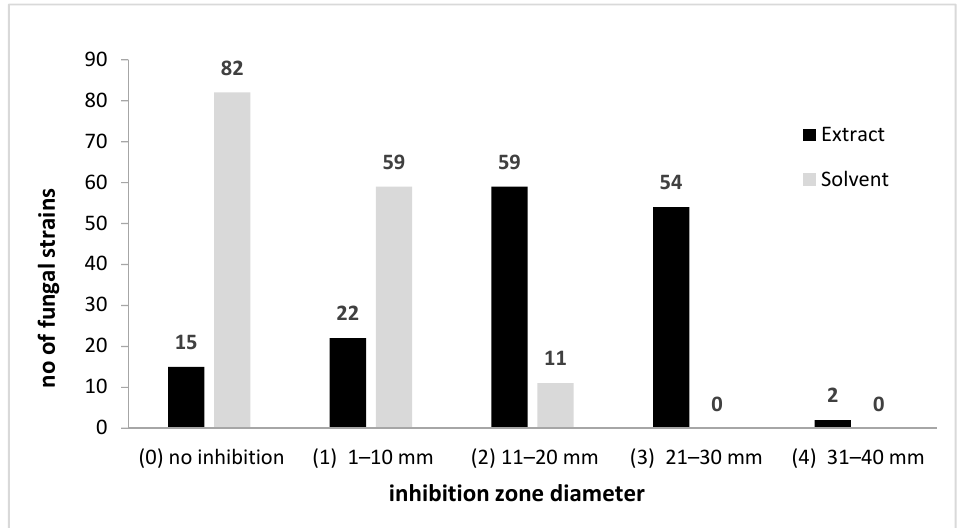
Figure 2. A. sativum inhibitory activity against fungal strains expressed by arbitrary units of growth inhibition zone diameter.